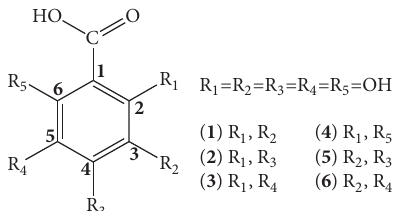
Figure 1: Structural formulas of the examined dihydroxybenzoic acids ( 1 , 2 , 3 , 4 , 5 , and 6 ) with atom labeling indicated and their trivial